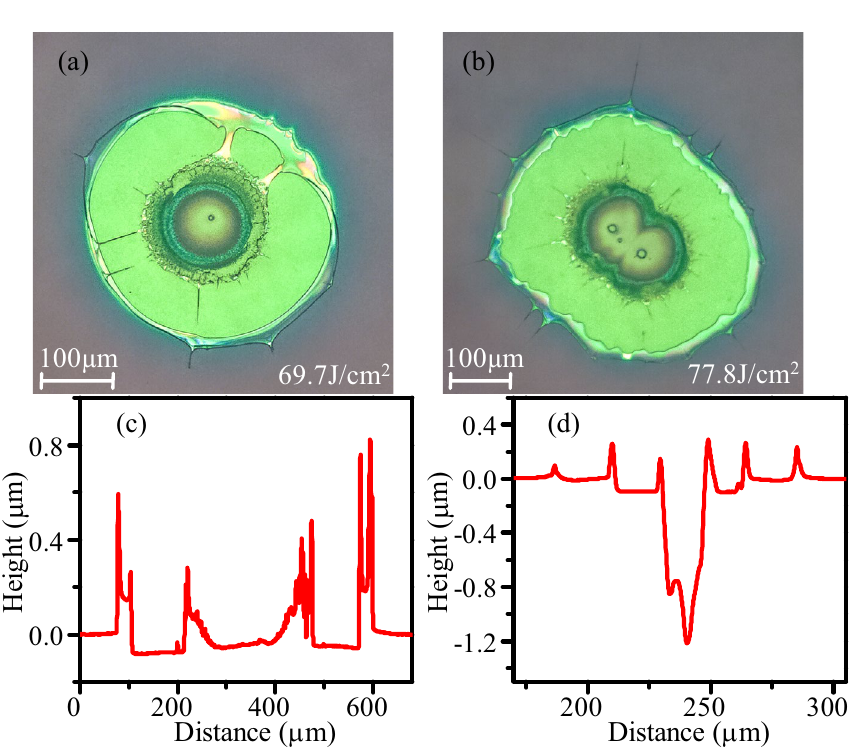
Figure 3. Optical microscope morphologies and damage pits depth of Al 2 O 3 /SiO 2 coatings after laser damage test, ( c ) and ( d ) correspond to the depth distribution of ( a ) and ( b ),